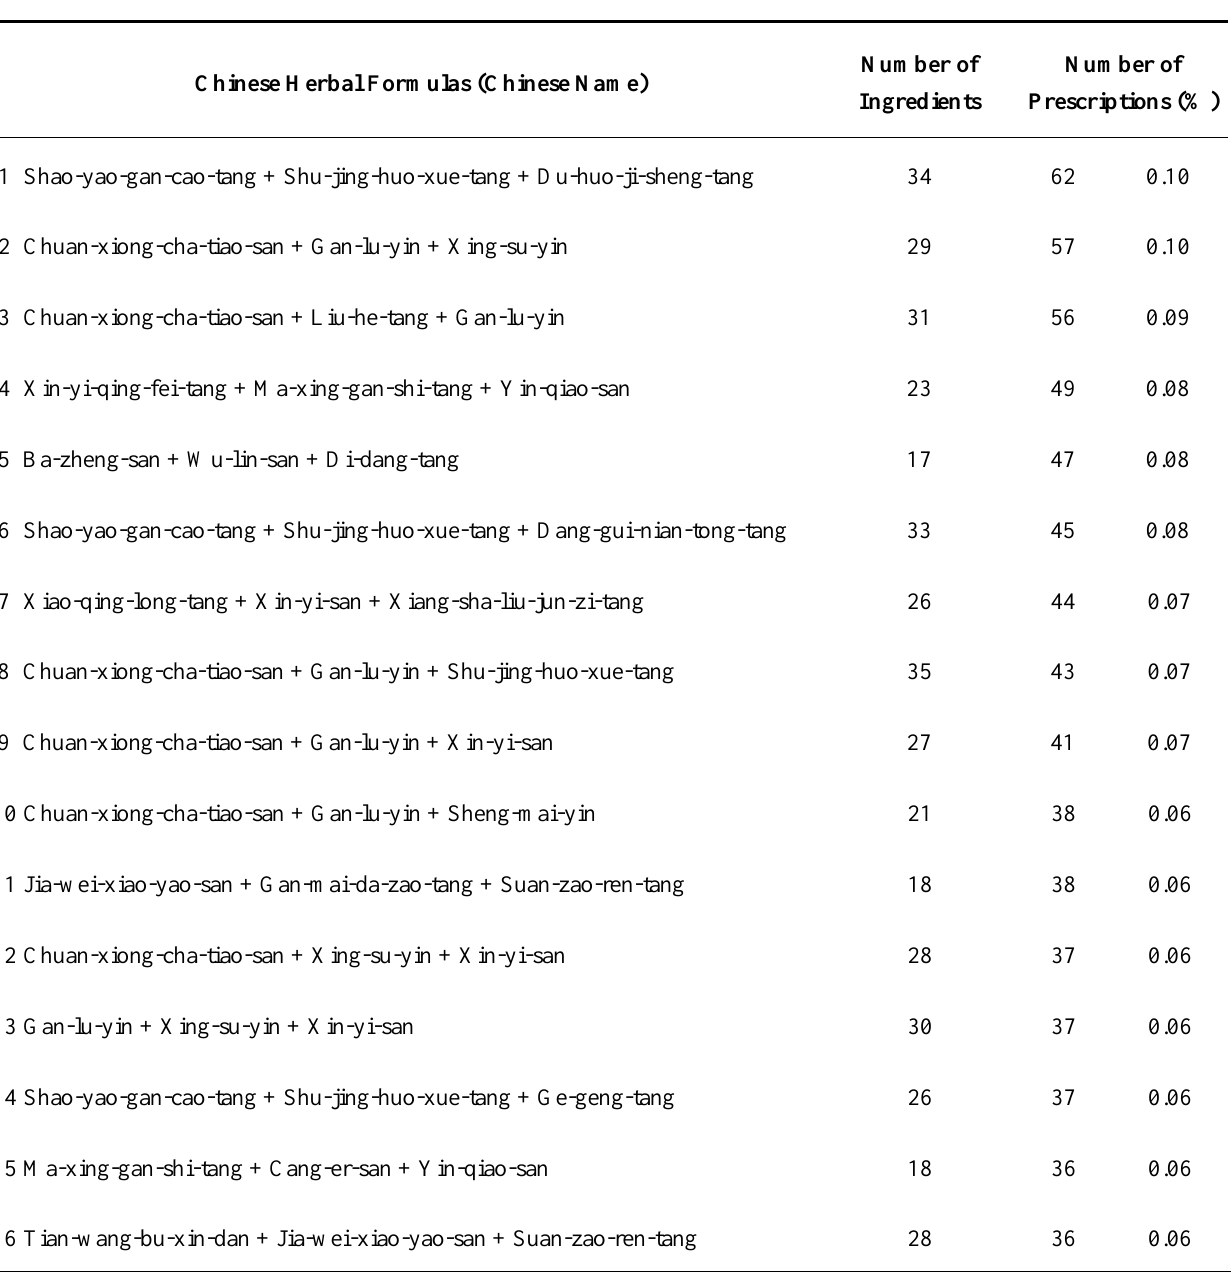
Table 6. The most common three-formula combination of Chinese herbal medicine (CHM) in a single prescription in Taiwan in 2010 (total prescription number n = 59,790). Chinese Herbal Formulas (Chinese